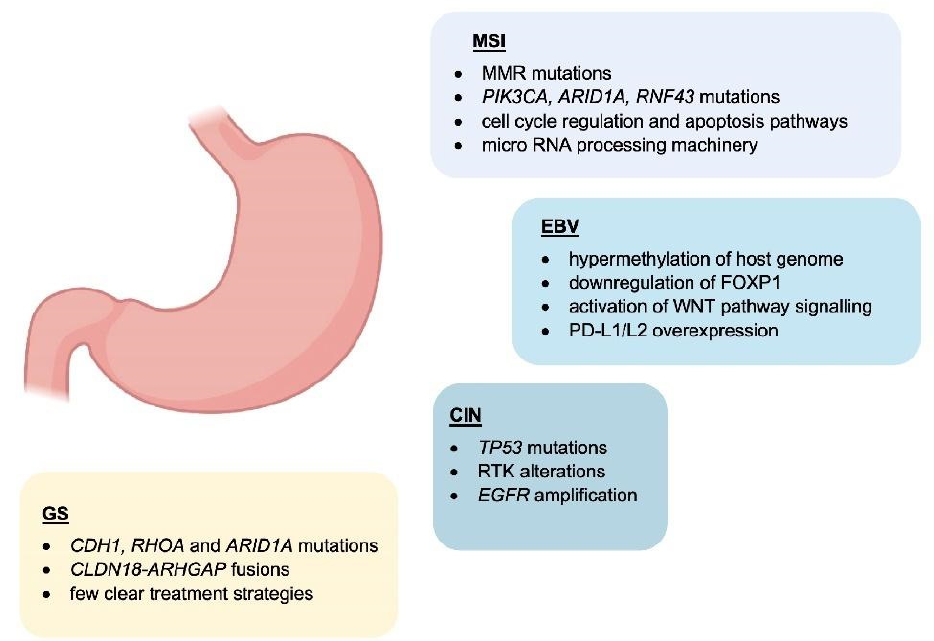
Figure 1. Main features of GC subtypes. Schematic representation of the molecular characteristics associated with GC molecular subtypes.